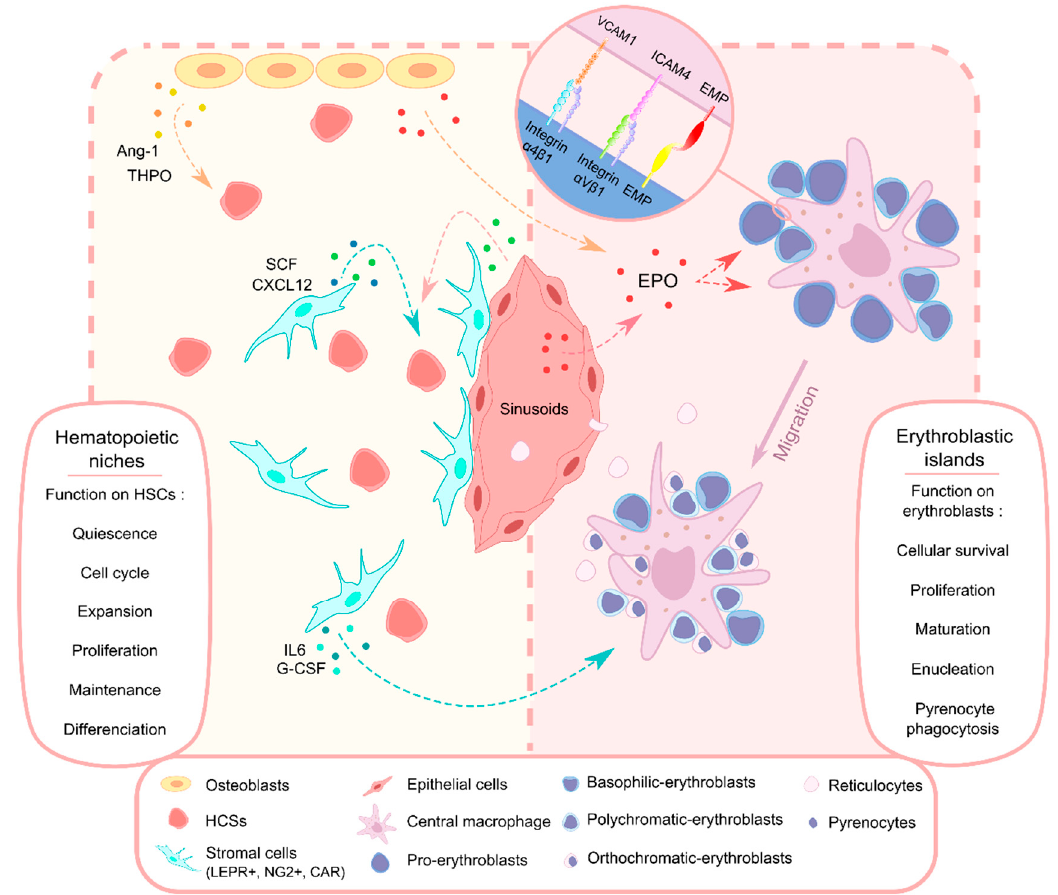
Figure 1. Summary of cell to cell dialog within the erythroblastic niche. Left panel: osteoclasts, stromal cells, and epithelial cells from the sinusoids act simultaneously to maintain the pool of undifferentiated HSC. Right panel: these cells produce cytokines inducing the differentiation of erythroblasts which interact with macrophages within the erythroblastic island, promoting proliferation and terminal differentiation.